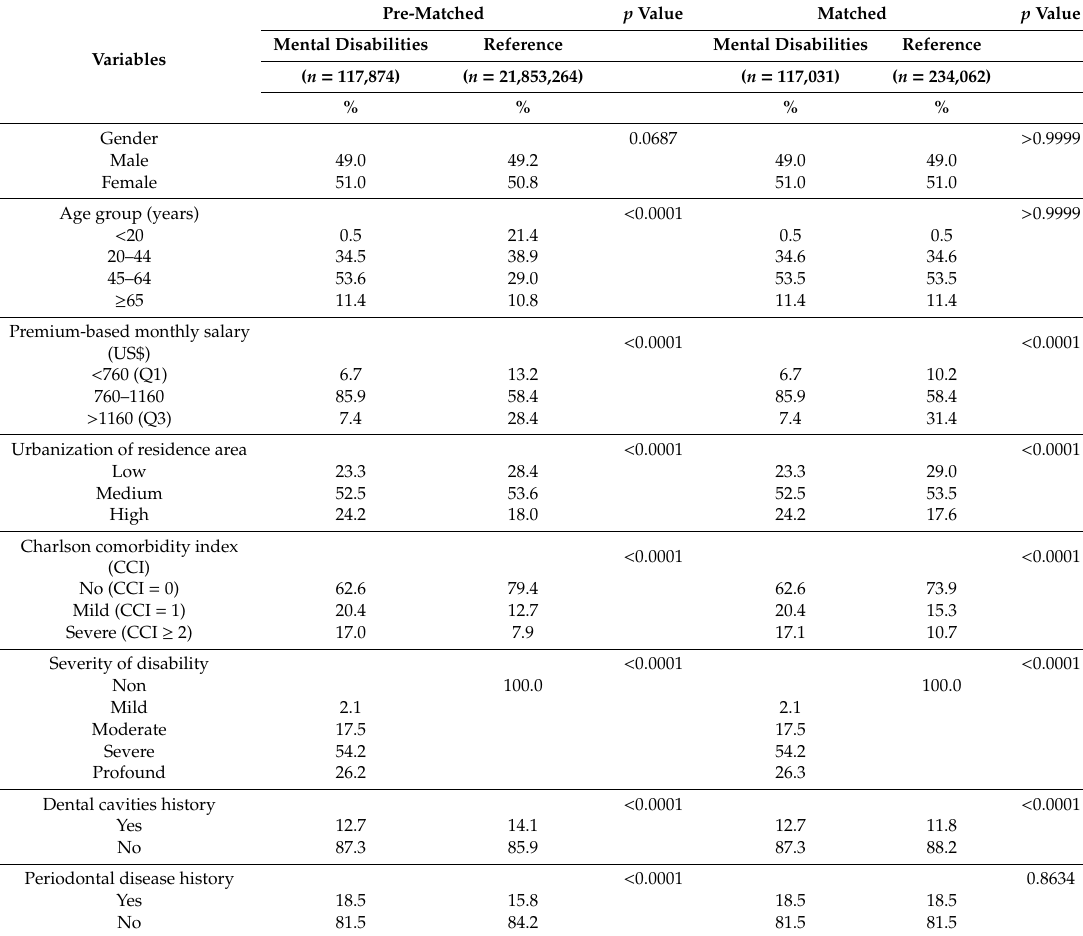
Table 1. Characteristics of individuals in the MD and reference groups before and after matching. Pre-Matched p Value Matched p Value Mental Disabilities Reference Mental Variables